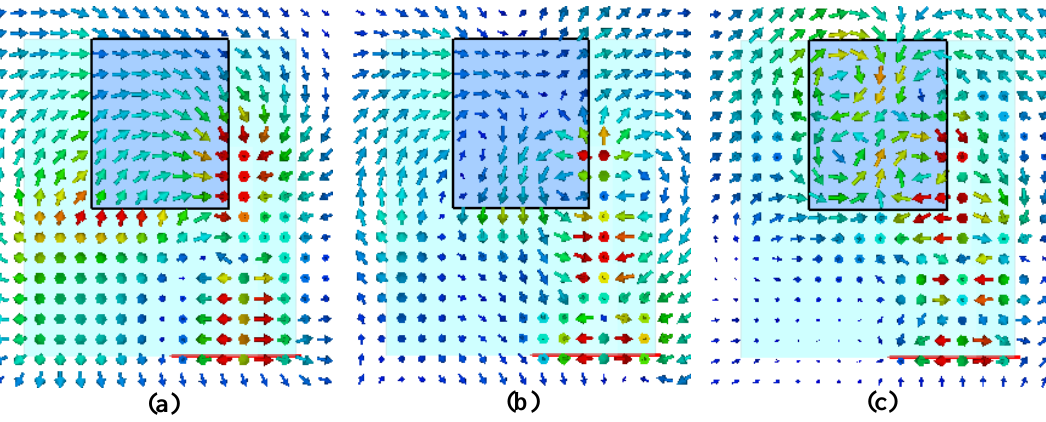
Figure 4. Simulated E-fields of reference Antenna III: ( a ) TE11 δ mode at 4.04 GHz; ( b ) TE21 δ mode at 8.49 GHz; and ( c ) TE22 δ mode at 11.69 GHz.